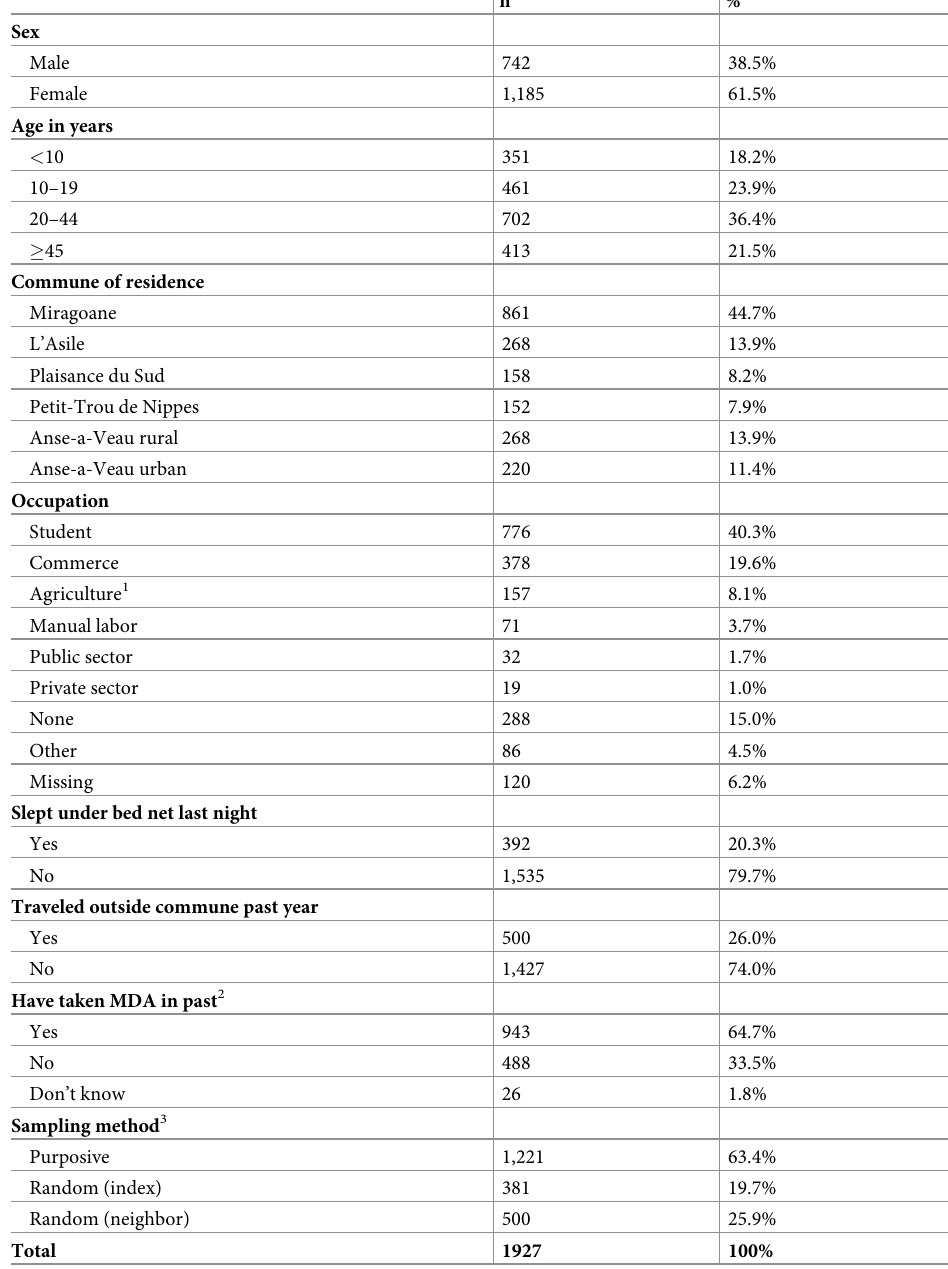
Table 1. Demographics and participant characteristics among survey respondents in Nippes Department, Haiti, July-August 2019. N = 1,927.